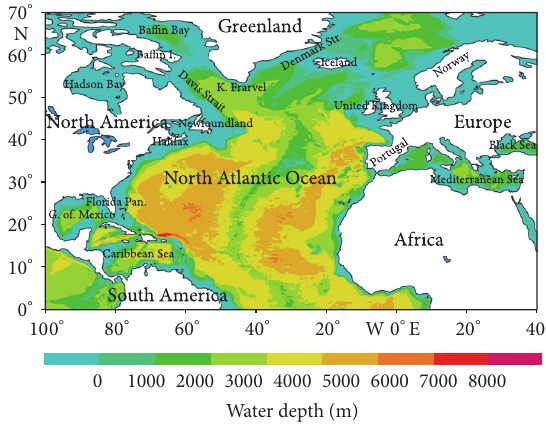
Figure 1: Topography of the North Atlantic.